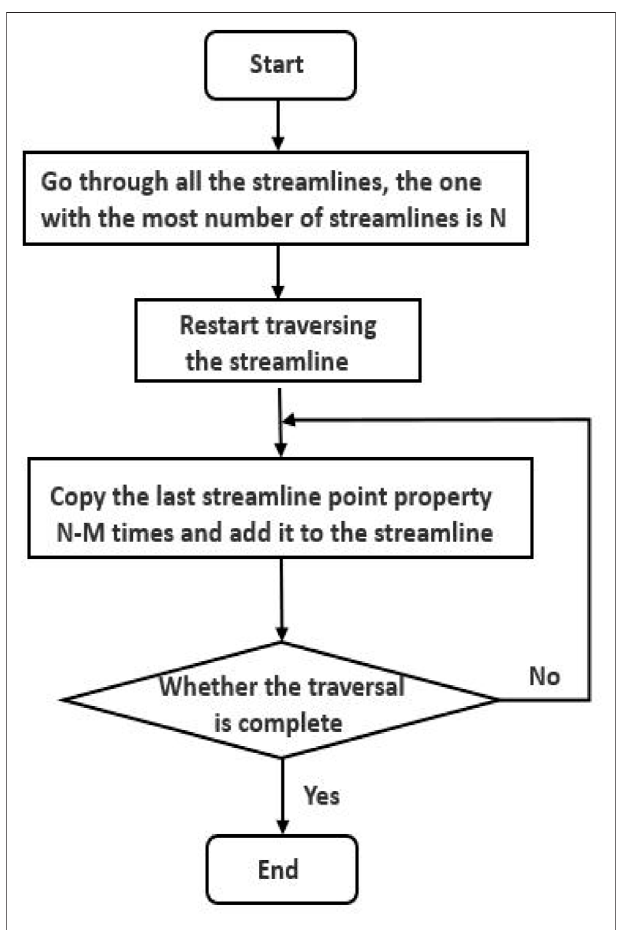
FIGURE2| FlowchartofthestreamlinePCAdimensionreductionmatrix construction.